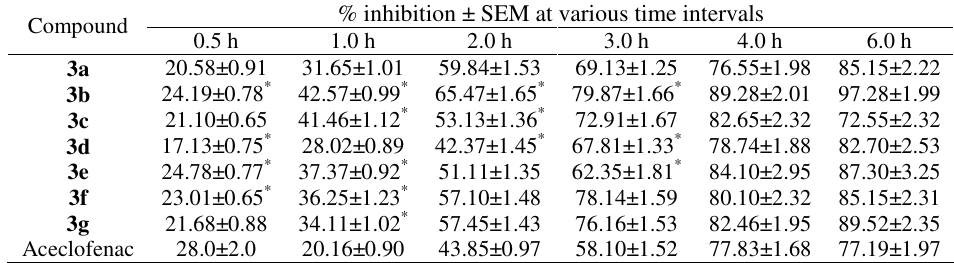
Table 3. Anti-inflammatory activity of chalcones 3